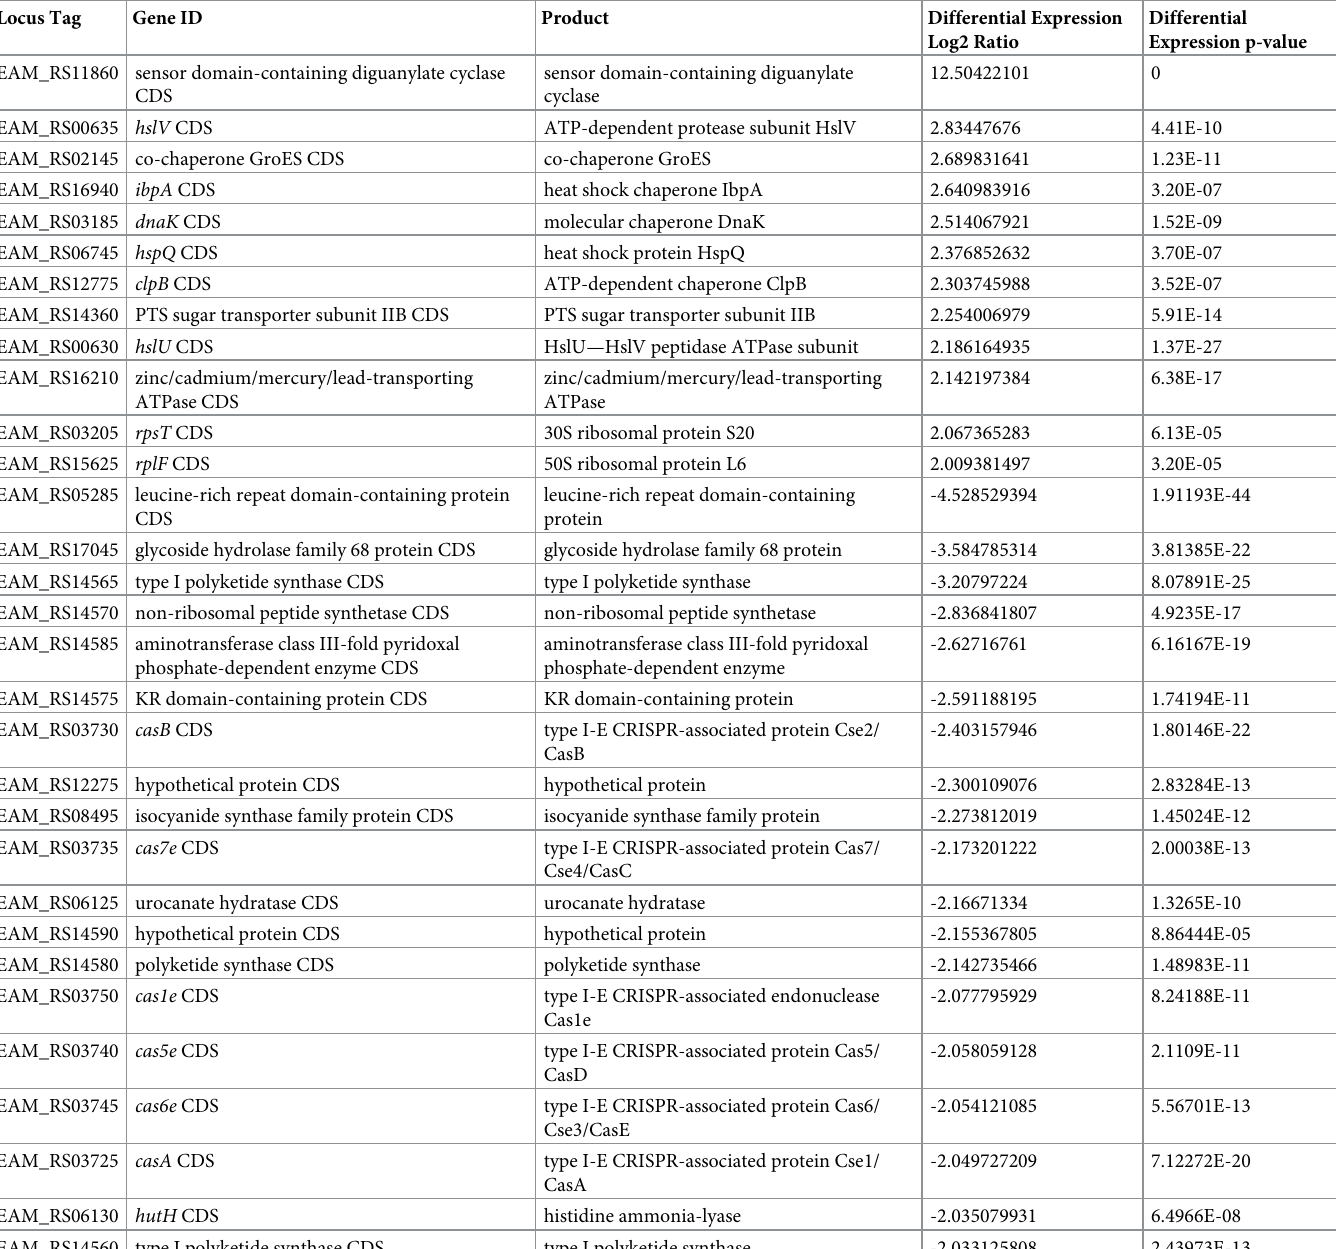
Table 7. A list of the statistically significant differentially regulated genes (Log2 fold change of two) in Ea1189 Δ 8+ edcE OE relative to Ea1189 Δ 8. Locus Tag Gene